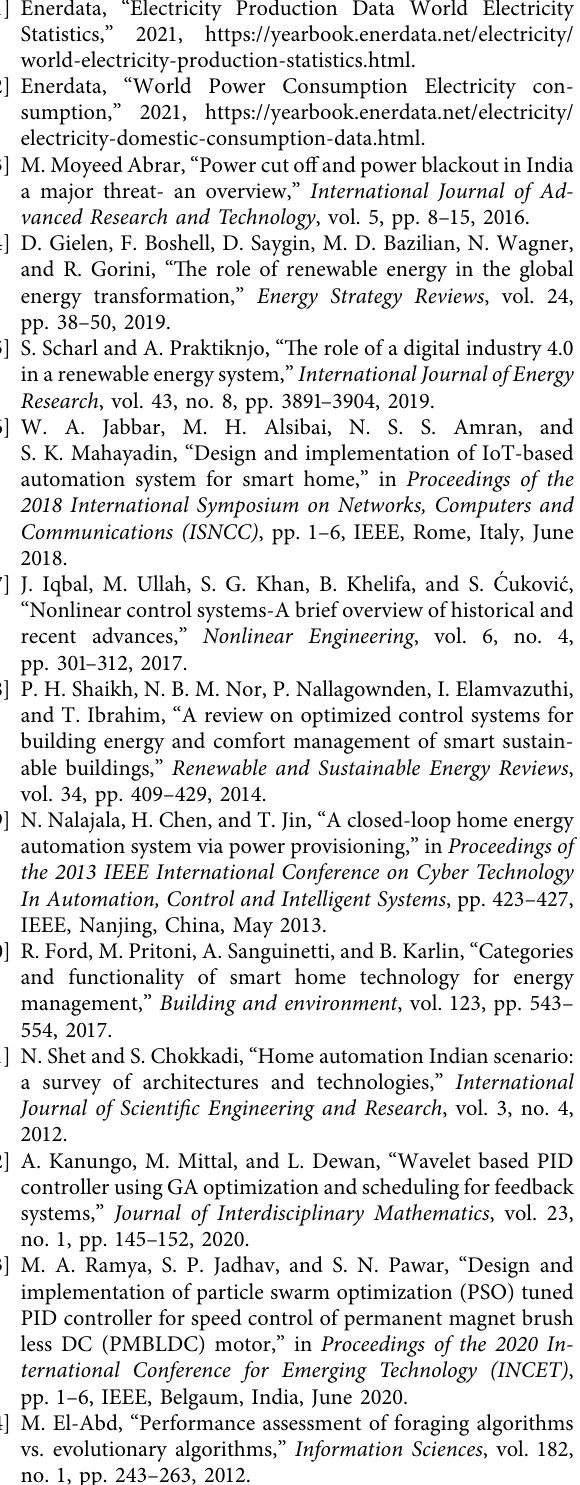
Table 11: Consumption of current for remote control.